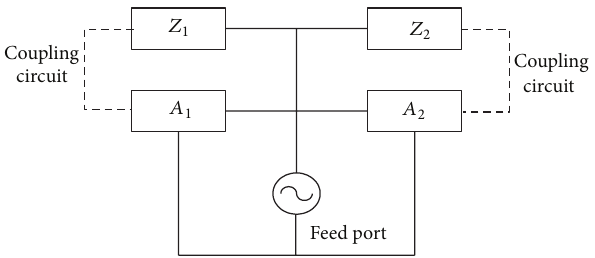
Figure 5: Equivalent circuit of the antenna array. 𝑍 1 and 𝑍 2 represent loading metal strips, and 𝐴 1 and 𝐴 2 represent active